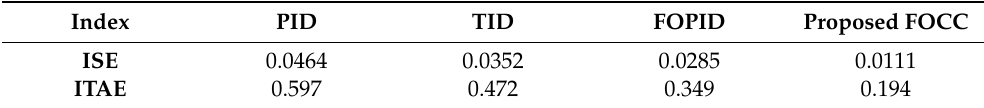
Table 3. ITAE and ISE performance criteria of the MG frequency deviation employing different controllers.